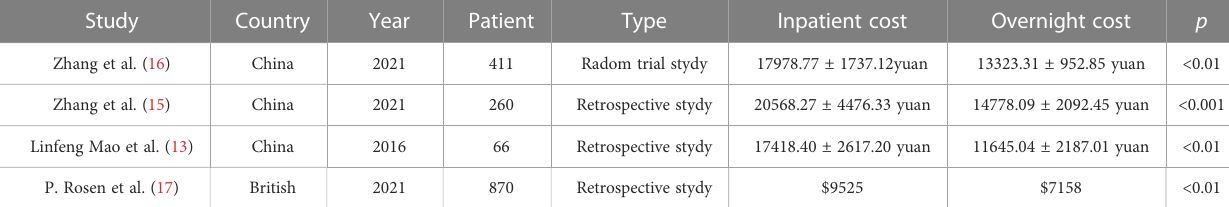
TABLE 2 The cost data of inpatient and overnight